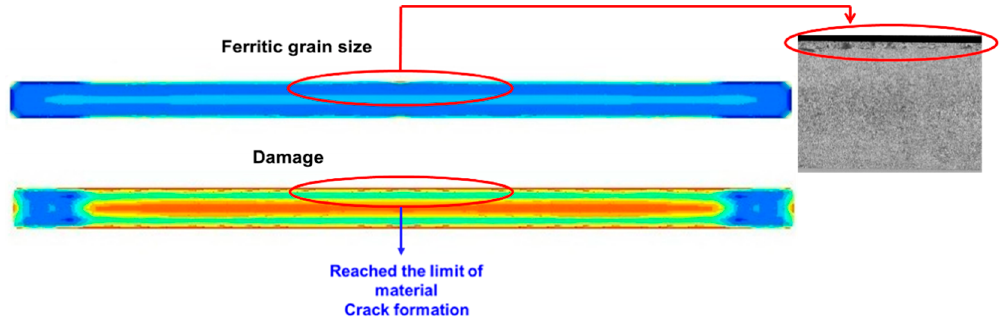
Figure 16. Comparison between macrography of the bar and the grain growth resulting from the maps of ferrite grain size and damage.